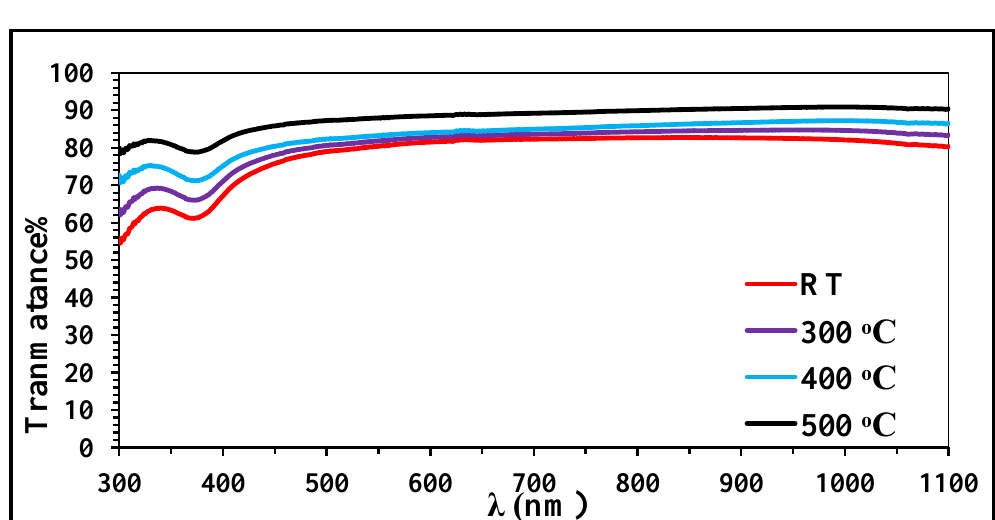
Fig. 5: The transmitance of the Cr